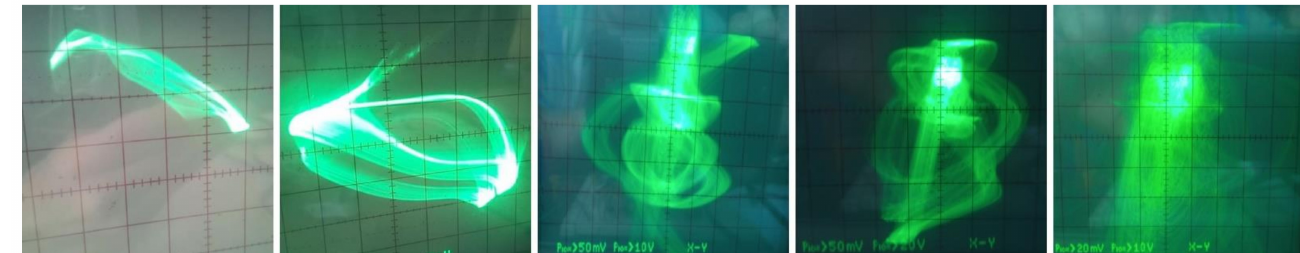
Figure 14. Selected oscilloscope screenshots captured during measurement of cascoded